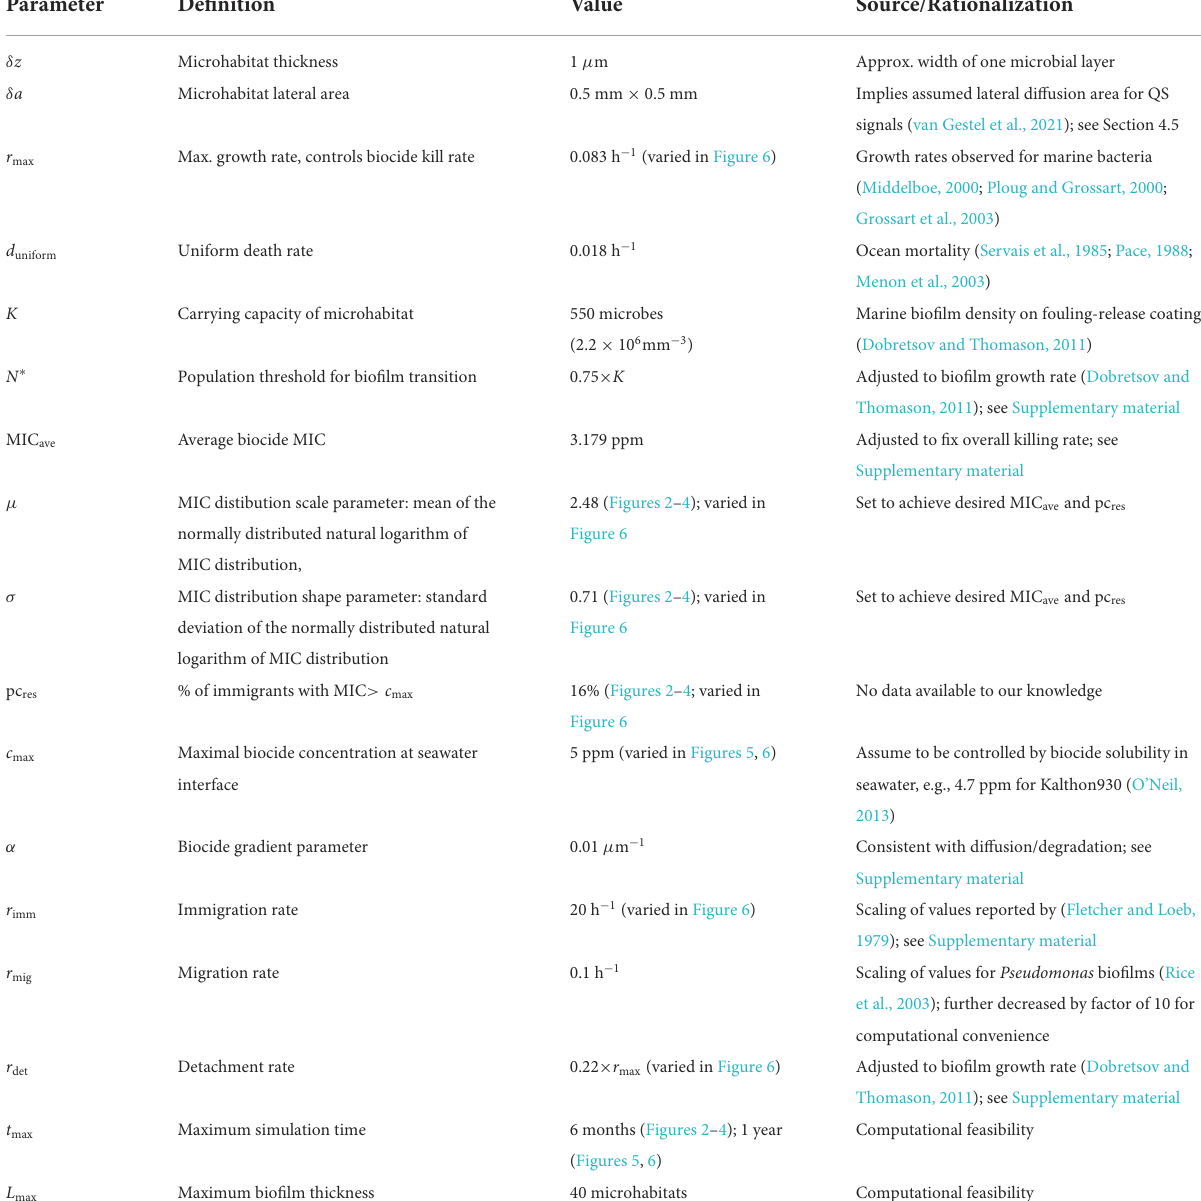
TABLE 1 Parameters used in our computational